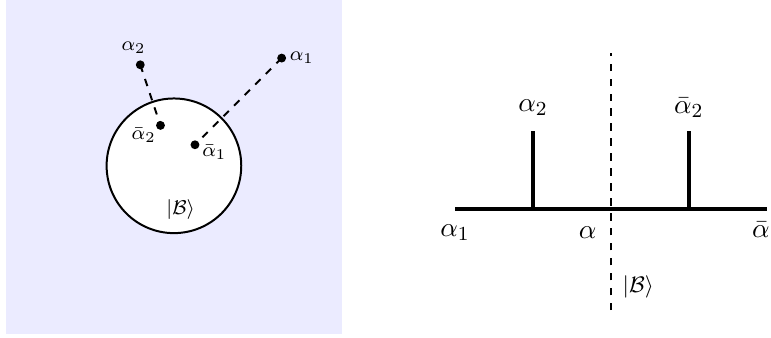
Figure 2 . Left: Schottky double. Right: trivalent graph of the bulk two-point function. In both (cid:12)gures we denote (cid:22) (cid:11) = 2 Q (cid:0) (cid:11) for